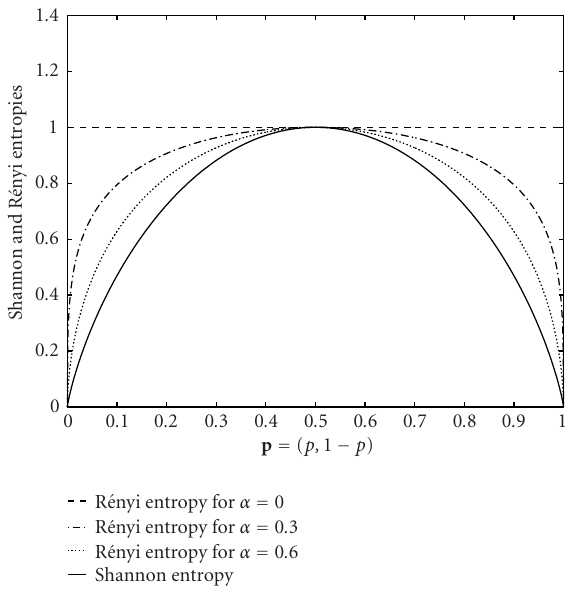
Figure 7: Shannon and R´enyi entropies of Bernoulli distribution p = ( p ,1 − p ) for di ff erent values of α .